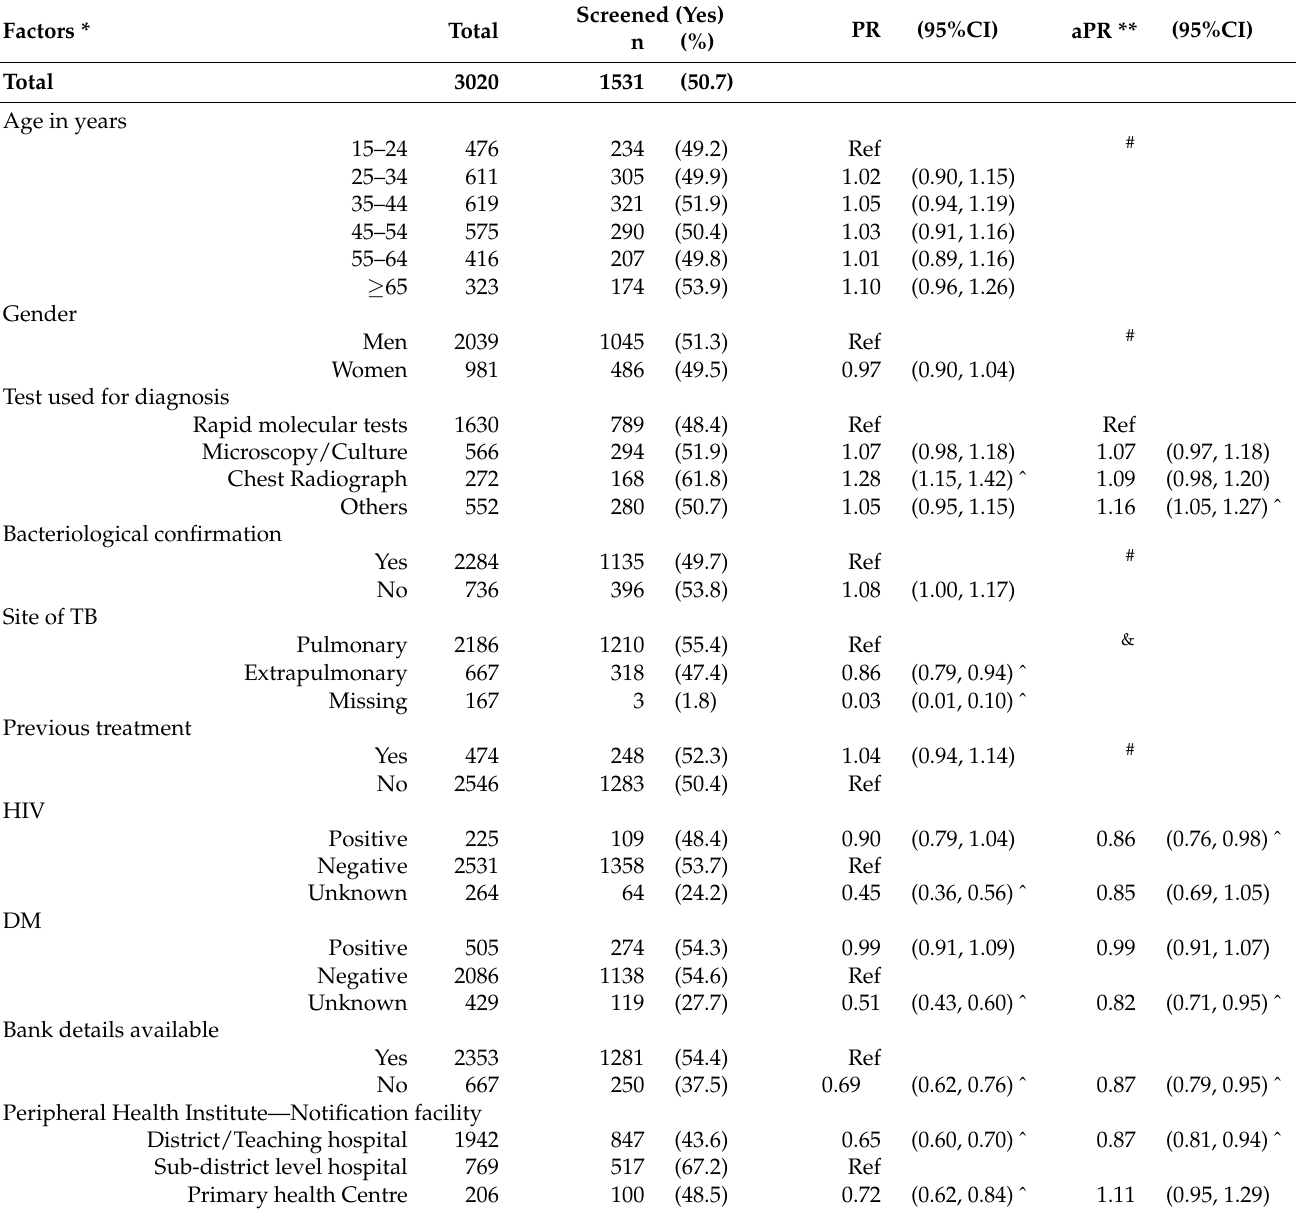
Table 2. Factors associated with screening for ‘high risk of severe illness @ at notification among adults ( ≥ 15 years) with TB (without known drug-resistant disease at diagnosis) from public health facilities of 16 districts in Karnataka,